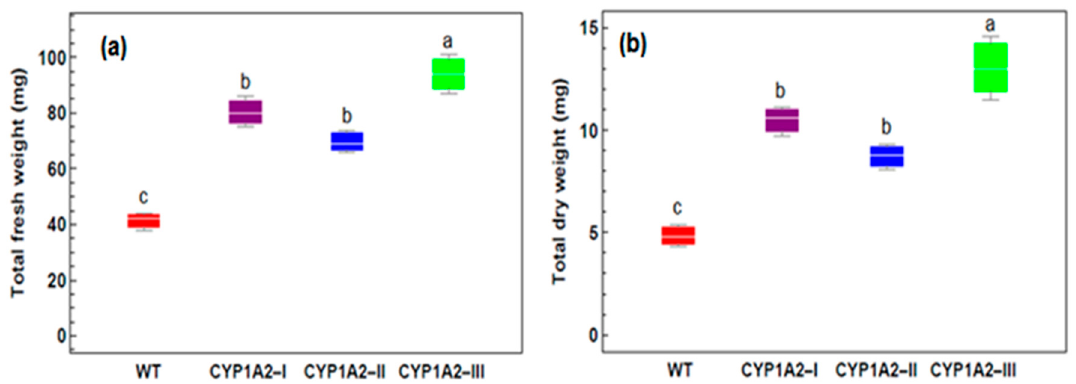
Figure 2 . Effects of isoproturon applied by foliar spray on the total fresh weight ( a ), and total dry weight ( b ) of wild type (WT) and CYP1A2 transgenic A. thaliana plants lines. Different lowercase letters indicate significant differences between the wild type and different lines of transgenic A. thaliana plants ( p < 0.05).